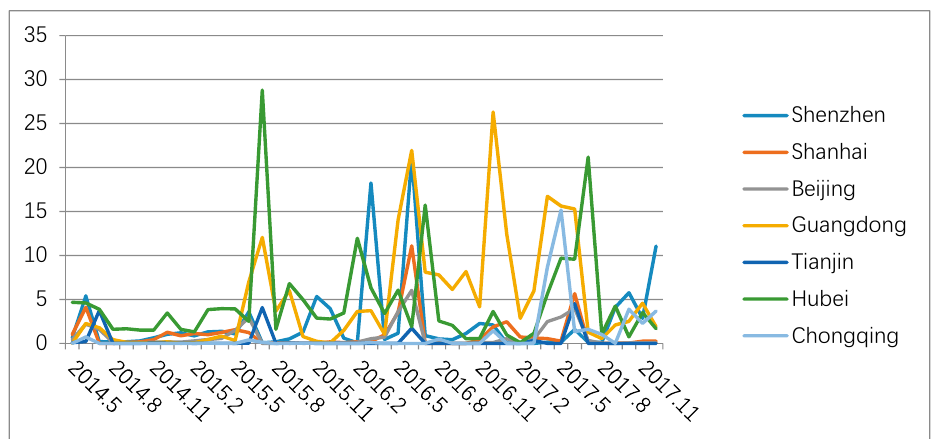
Figure 6. Monthly trade volume in seven-pilot carbon trade markets.